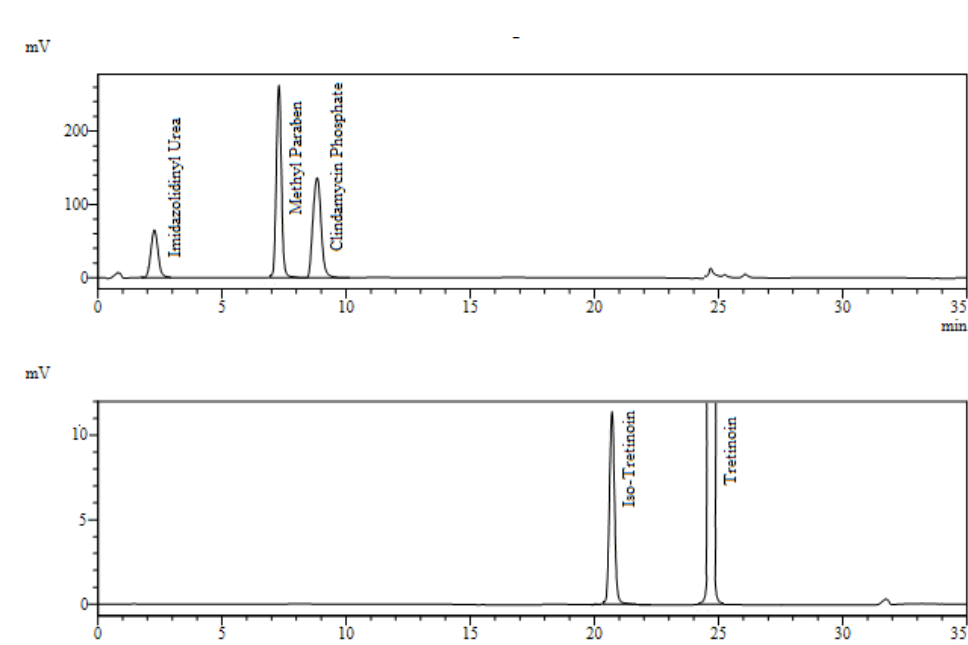
Figure 3. HPLC chromatogram of experimental gel preparation initial analysis. Peaks: imidazoli- dinyl urea, t R ∼ 2.2 min; methyl paraben, t R ∼ 7.3 min; clindamycin phosphate, t R ∼ 8.9 min; tretinoin, t R ∼ 24.8 min.